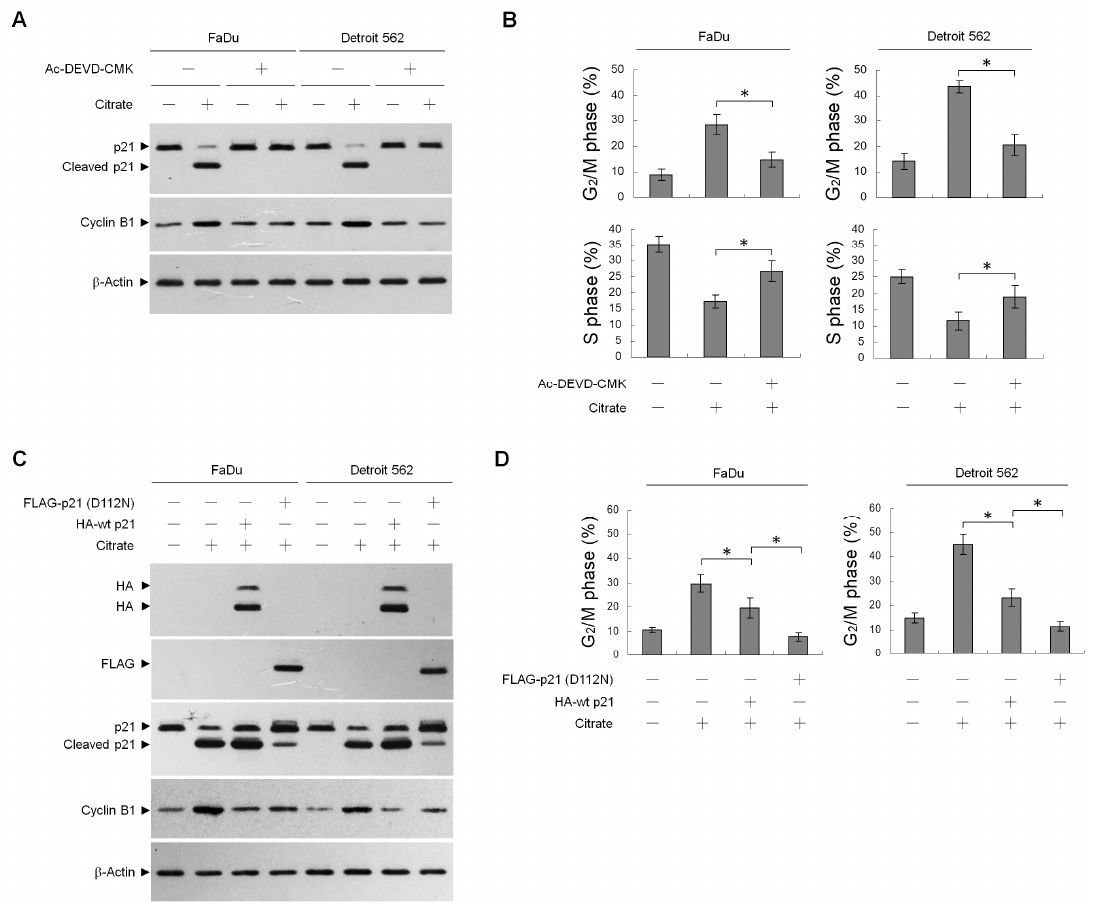
Figure 4. Citrate-induced caspase 3-mediated p21 cleavage is involved in the induction of G 2 / M phase cell cycle arrest. ( A , B ) Cells were treated with vehicle ( − ), citrate (10 mM), Ac-DEVD-CMK (10 µ M), or citrate (10 mM) plus Ac-DEVD-CMK (10 µ M) for 36 h. ( C , D ) At 12 h after transfection with an empty vector, HA-wt p21, or FLAG-p21 (D112N), the cells were treated with either vehicle ( − ) or citrate (10 mM) for 36 h. The levels of indicated proteins in the cell lysates and cell cycle phase were determined using Western blot analysis with specific antibodies and flow cytometric analysis of PI-stained cells, respectively. β -Actin was used as an internal control for sample loading. The values are presented as the means ± standard error of three independent experiments. * p < 0.05: significantly di ff erent from empty vector-transfected citrate-treated cells or wt-p21-transfected citrate-treated cells.